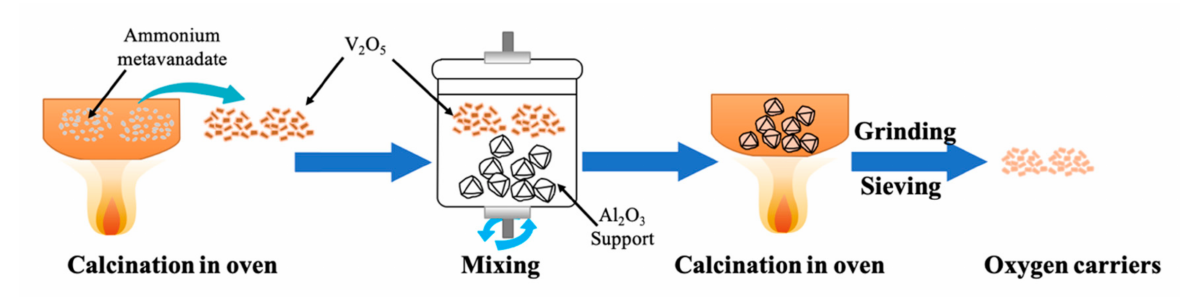
Figure 12. The preparation procedure of mechanical mixing